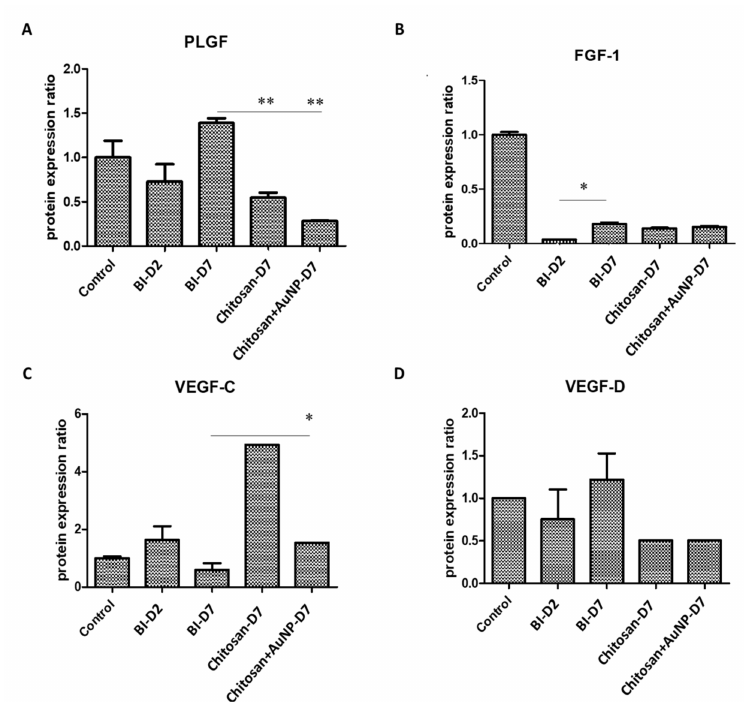
Figure 7. The protein expression of several angiogenesis biomarkers in rat burn wound tissues in the control, lesion, chitosan dressing, and AuNP-coated chitosan dressing groups. ( A ) FLGF; ( B ) FGF-1; ( C ) VEGF-C; ( D ) VEGF-D. Control = normal control group; BI D2 = lesion control group day 2 post-wounding; BI D7 = lesion control group day 7 post-wounding; Chi D7 = chitosan dressing treatment day 7 post-wounding; Chi + AuNP30 D7 = AuNP-coated chitosan dressing treatment day 7 post-wounding; * p < 0.05, ** p <